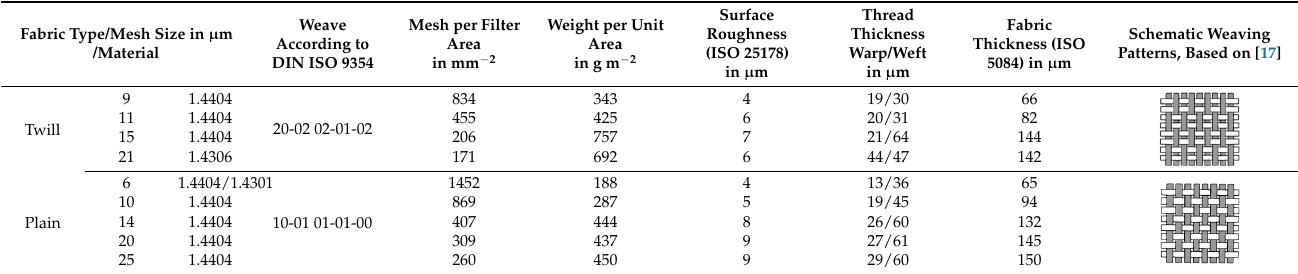
Table 3. Overview of metal-based multifilament fabrics.